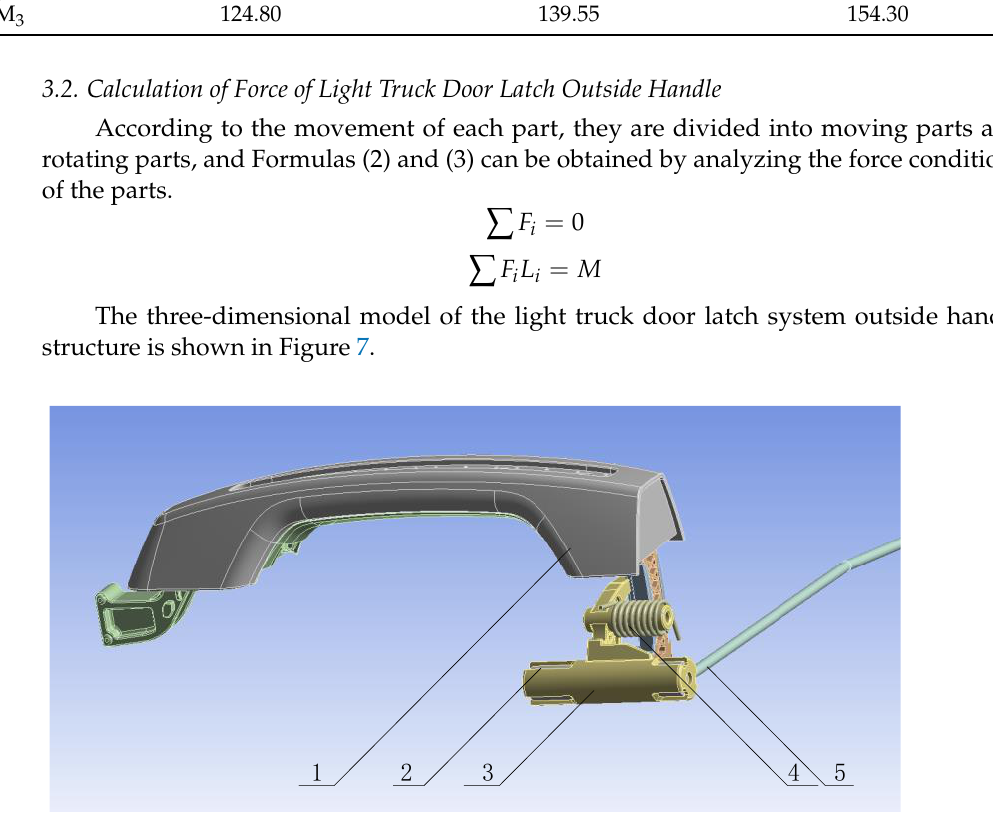
Figure 7. Outside handle structure. (1) Handle, (2) counterweight, (3) counterweight mechanism, (4) outside handle torsion spring, (5) lever.